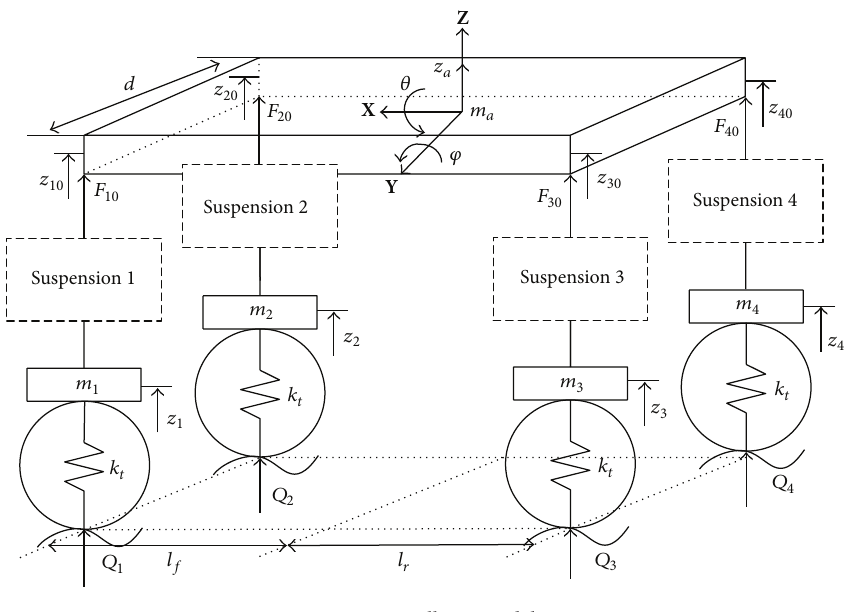
Figure 8: Full-car